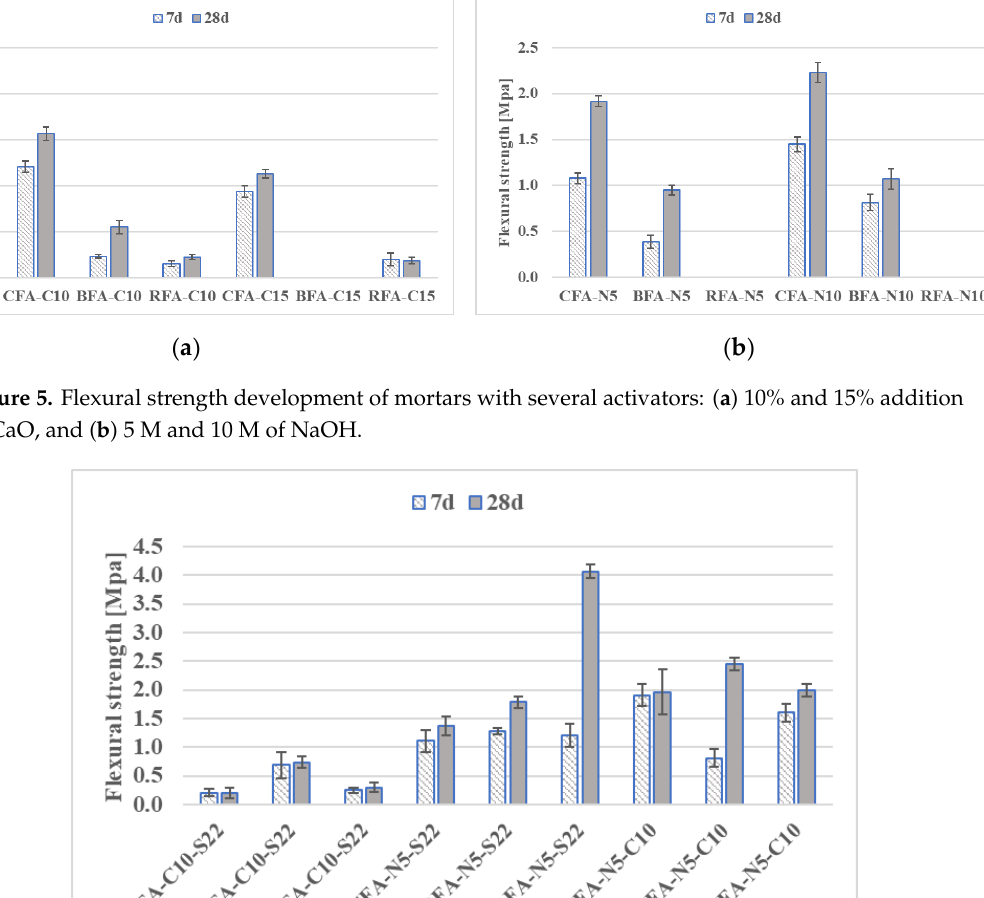
Figure 4. Examples of Espirit Spectrum Analysis for Bruker EDS: ( a ) RFA, point 42, aluminosilicate particles, ( b ) RFA, point analyzed as mullite, and ( c ) CFA, point analyzed as lime.